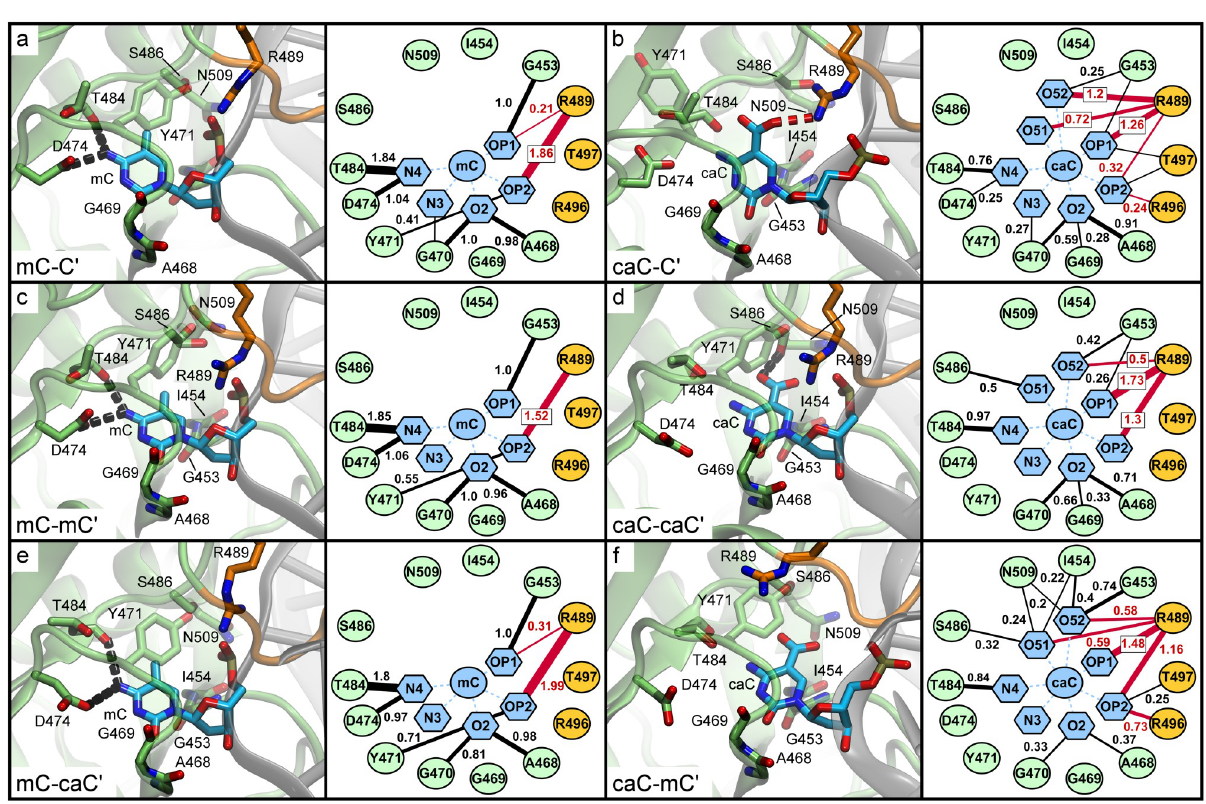
Fig 4. Interaction networks of the nucleotide binding pocket based on molecular dynamics simulations of UHRF1-SRA. Structures show representative conformations of the flipped-out modified DNA base within the binding pocket as observed during MD simulations. To the right of each structure a corresponding network of hydrogen bonds (black lines) and salt bridges (red lines) averaged over the course of the simulation is shown. Numbers next to edges show the average number of interactions per time frame. Edges representing interactions occurring in � 15% of simulation time are omitted for clarity. For node pairs featuring both hydrogen bonds and salt bridges, only salt bridges are displayed.